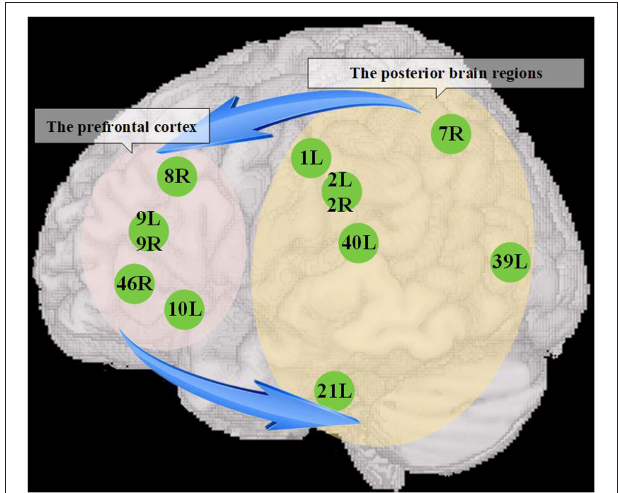
FIGURE 5 | The dysfunction of interactive information processing between the prefrontal cortex and posterior brain regions. The left elliptical shadow area covers the prefrontal cortex, and the right elliptical shadow area covers the posterior brain regions, and the figures in the shadow area show the seed brain regions with atypical entropy connectivity found in this study. The blue arrow represents that there might be a reduced mutual information transmission between them, which further contributed to accelerate the deoptimization of brain